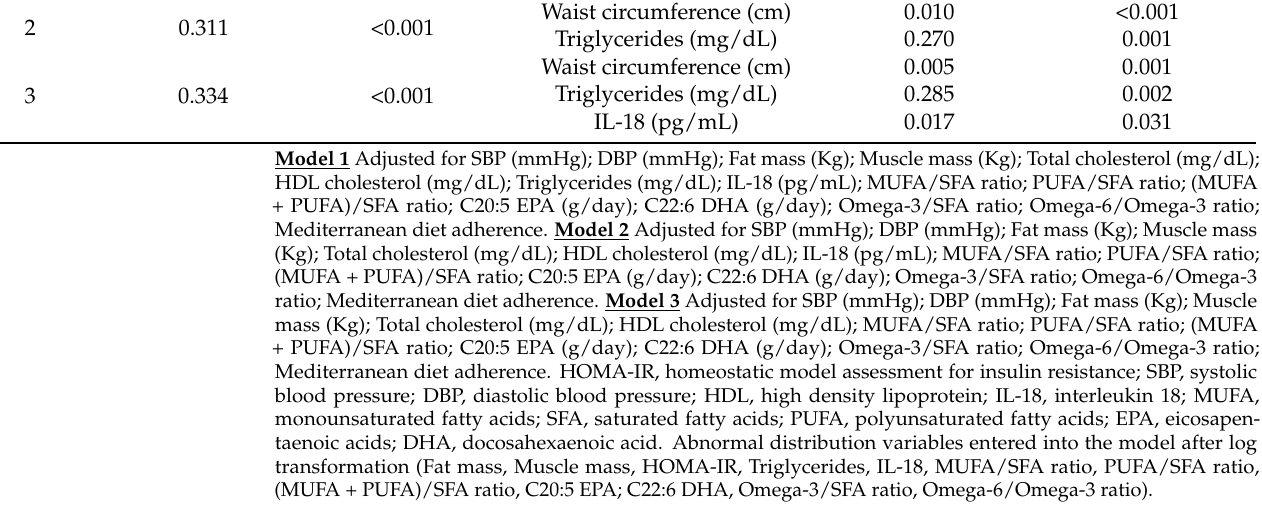
Table 5. Multiple linear regression model indicating predictors of